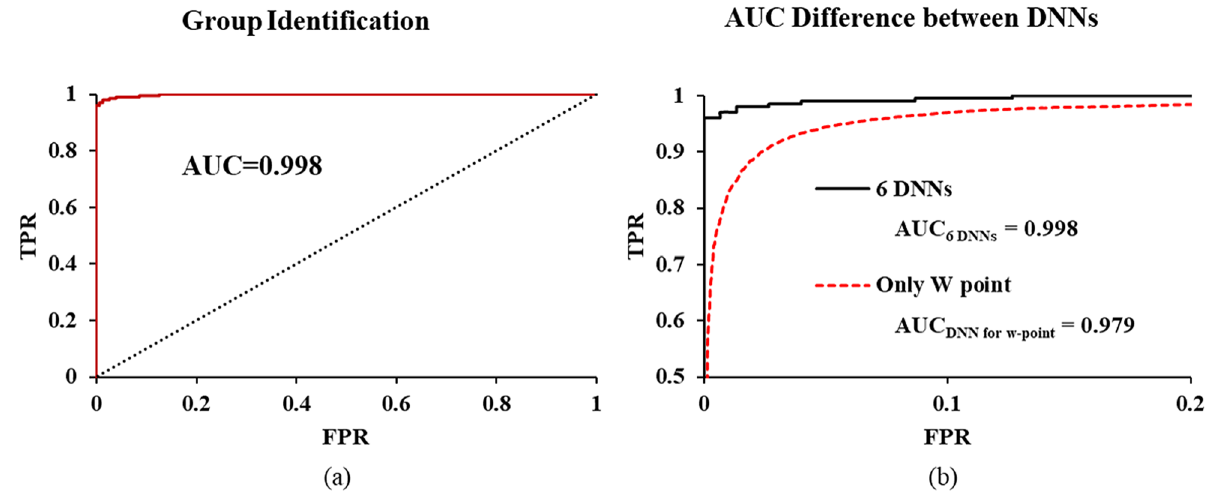
Figure 4. Accuracy of group identification for ( a ) reference data (75) and ( b ) test data